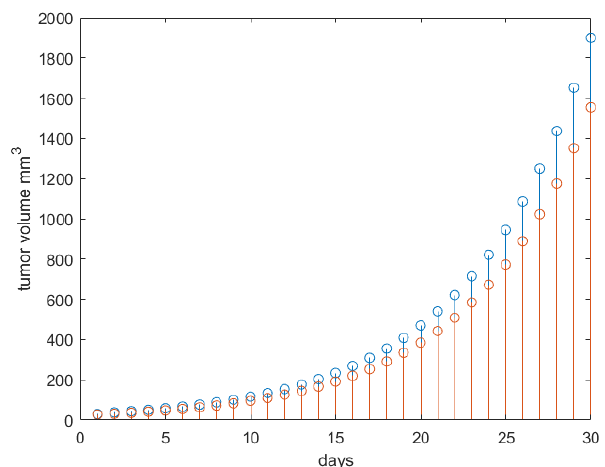
Figure 2. The total tumor growth volume (blue stems) and corresponding necrotic tumor volume (red stems) for no treatment.